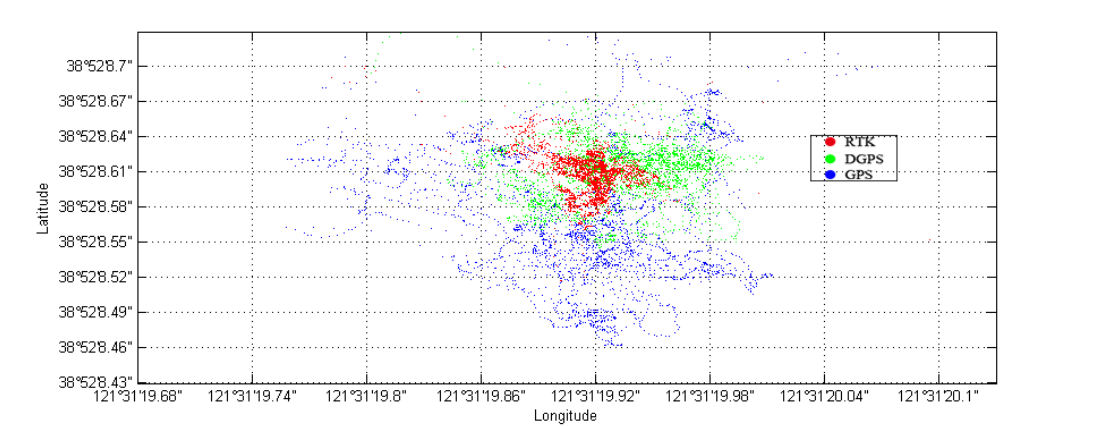
Figure 7. Real-time experimental results for static